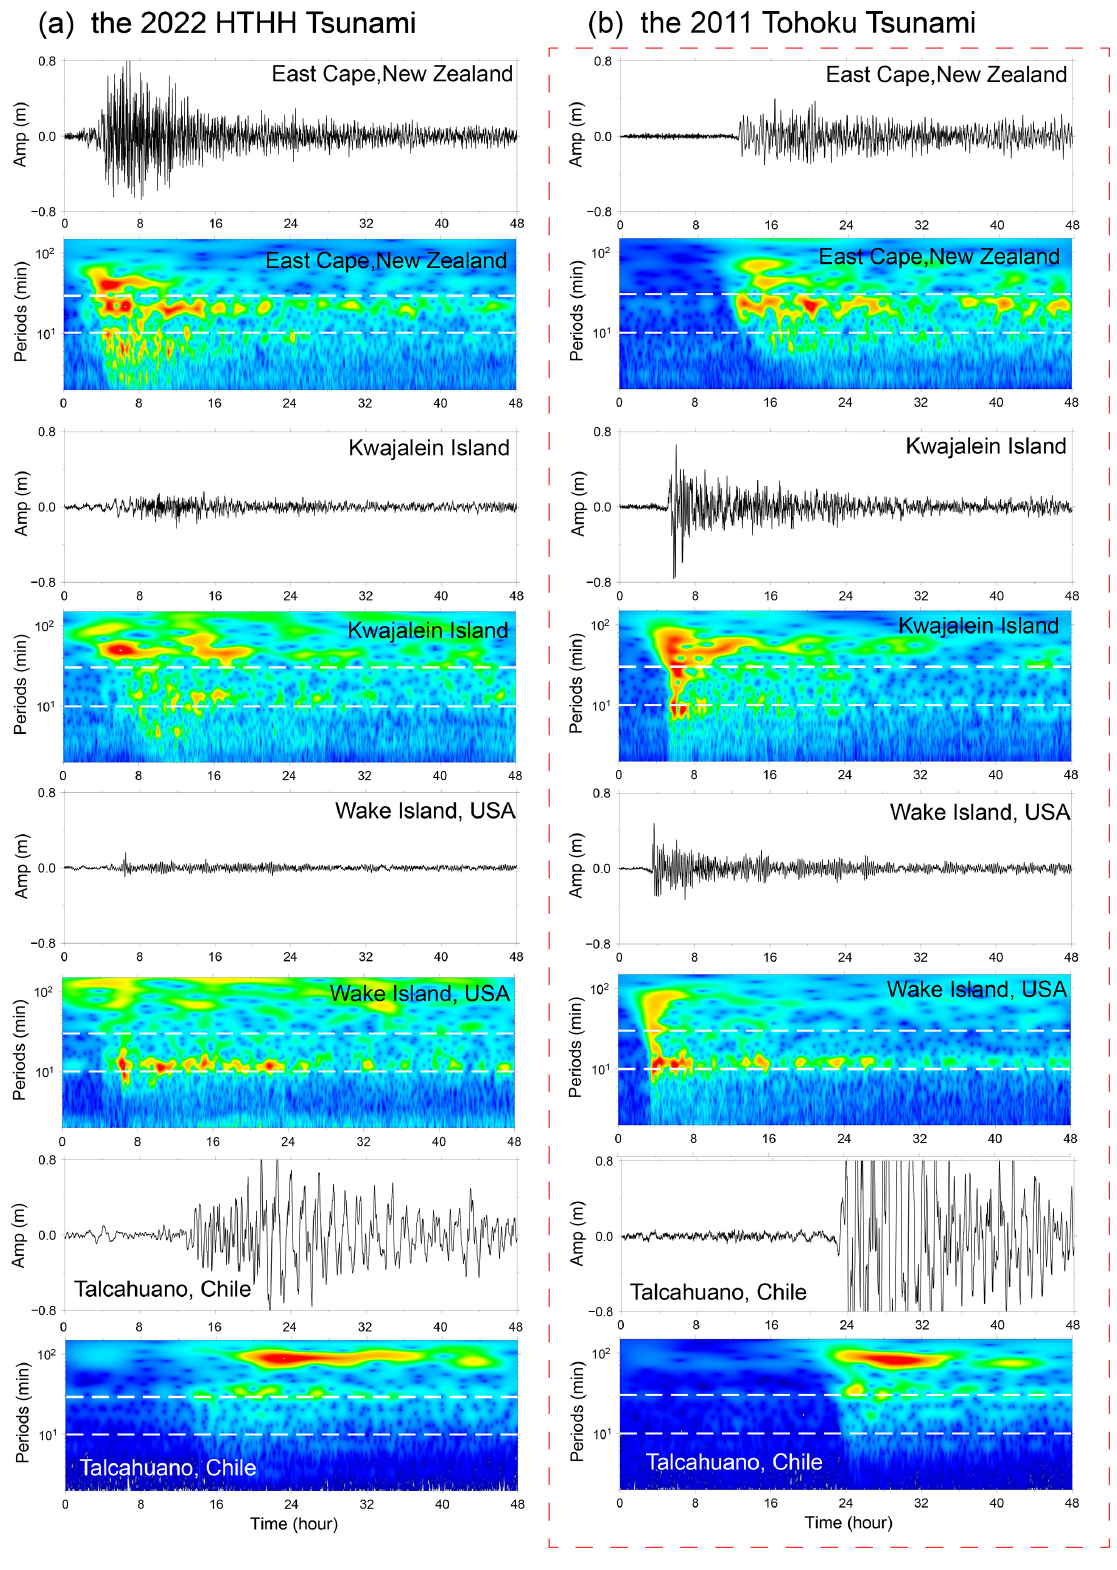
Figure 11. Wavelet analysis of tsunami waveforms recorded by four tide gauges during (a) the 2022 HTHH tsunami event and (b) the 2011 Tohoku tsunami event. Horizontal white dashed lines, respectively, mark reference periods of 10 and